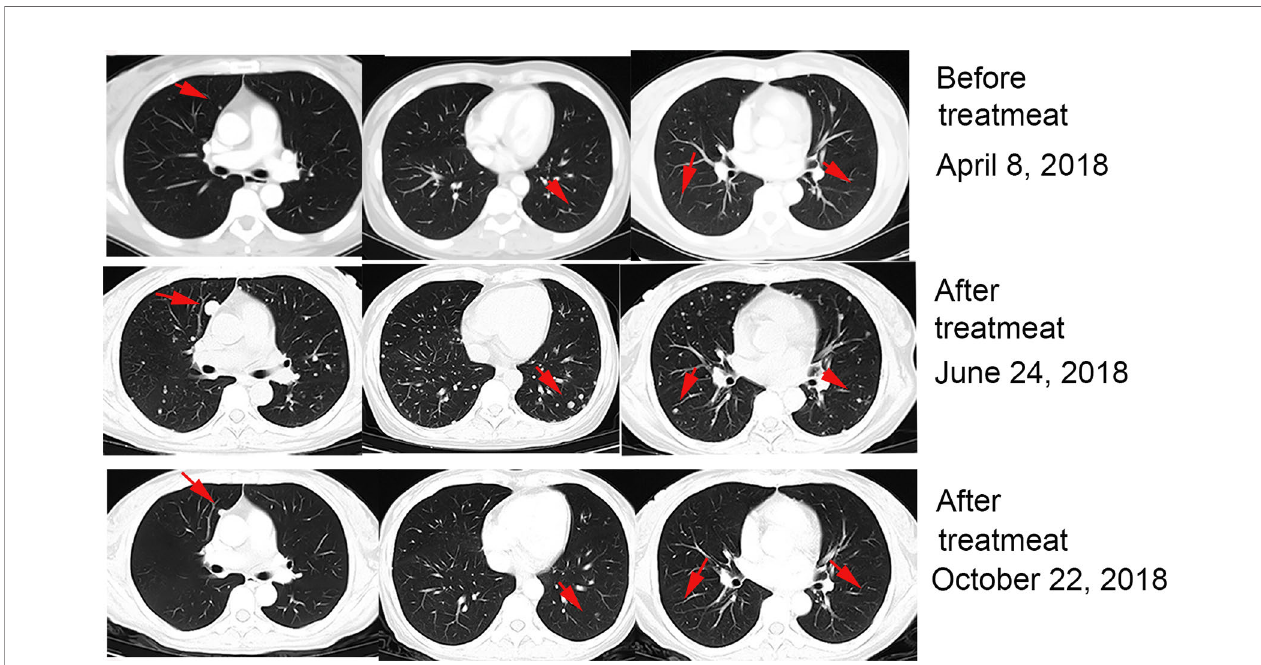
FIGURE 1 | Patient exhibited pseudoprogression of pulmonary lesions after 2 months of treatment with nivolumab plus CIK cell transfer and achieved a partial remission after 4